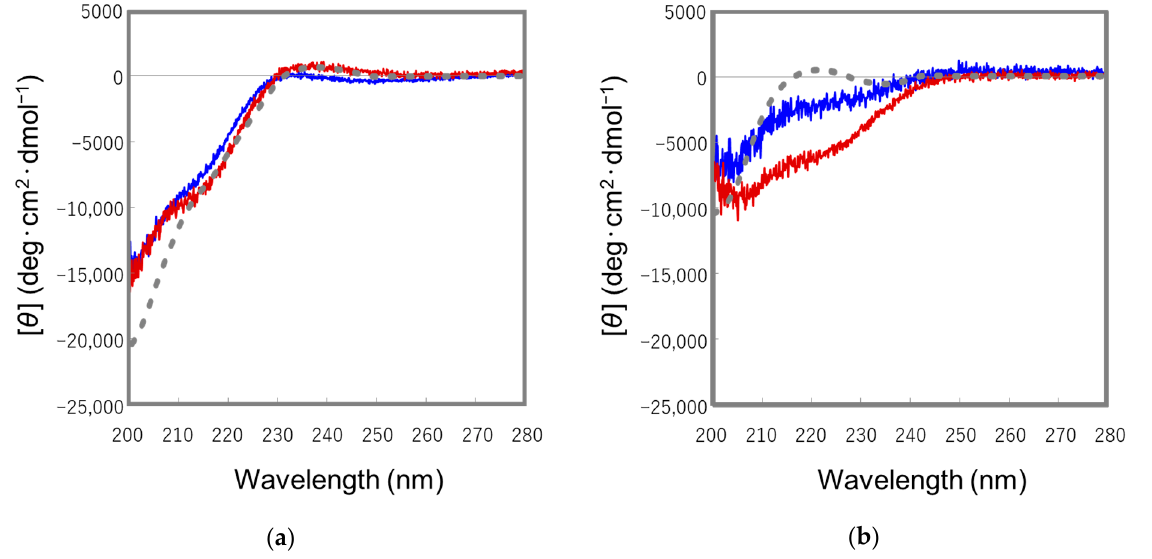
Figure 4. CD spectra of the native forms ( a ) and topological isomers ( b ) of the ST p peptides. The red, blue, and gray colored lines represent the CD spectra of the [ D -Cys 5 ,Asp 7 ,Val 8 , D -Lys 16 ]-ST p (5- blue, and gray colored lines represent the CD spectra of the [D-Cys 5 ,Asp 7 ,Val 8 ,D-Lys 16 ]-ST p (5-17), 17), [Mpr 5 , D -Lys 16 ]-ST p (5-17), and wild type ST p (5-17) peptides, respectively. [Mpr 5 ,D-Lys 16 ]-ST p (5-17), and wild type ST p (5-17) peptides,